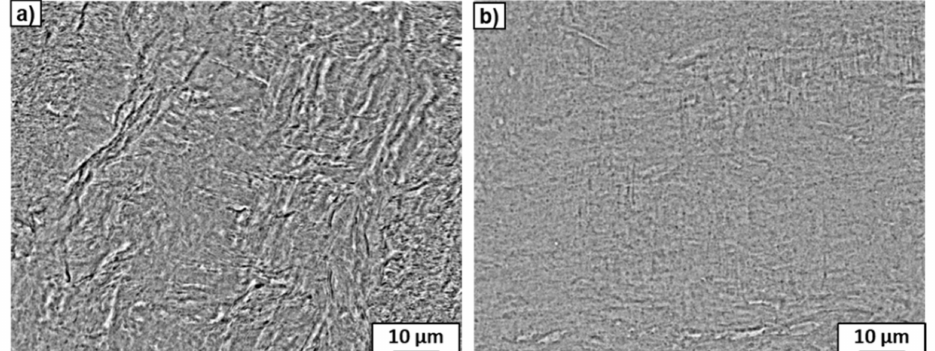
Figure 8. SEM micrographs of the Ti–2wt.% Mo ( a ) and Ti–18wt.% Mo ( b ) alloys after